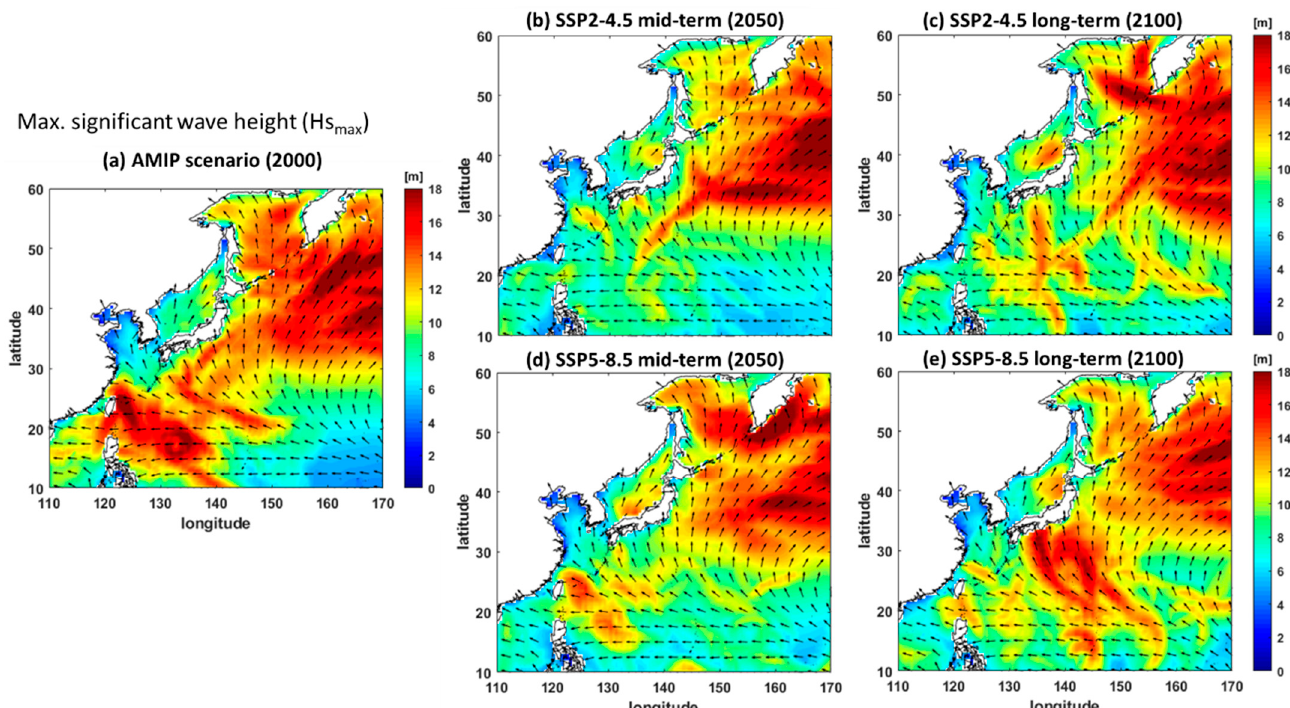
Figure 6. Annual maximum significant wave height (max. H s in m) results: ( a ) AMIP scenario result for 2000, ( b ) SSP2-4.5 medium-term, ( c ) SSP2-4.5 long-term, ( d ) SSP5-8.5 medium-term, and ( e ) SSP5-8.5 long-term scenarios.